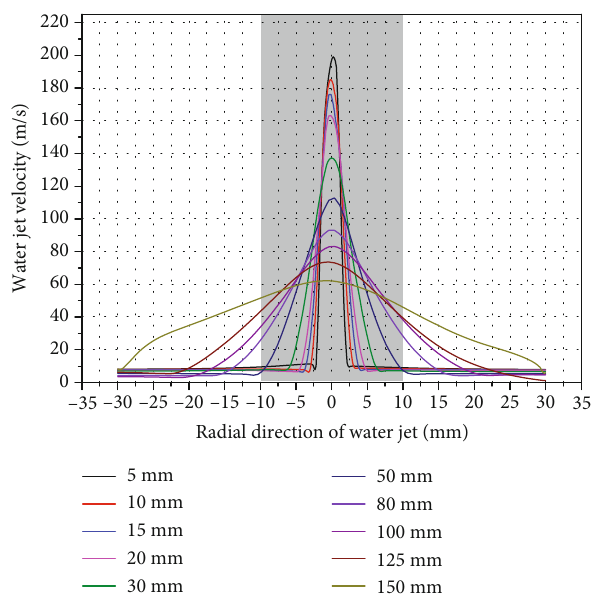
Figure 10: Variations of jet velocity on the radial cross-sections at di ff erent target